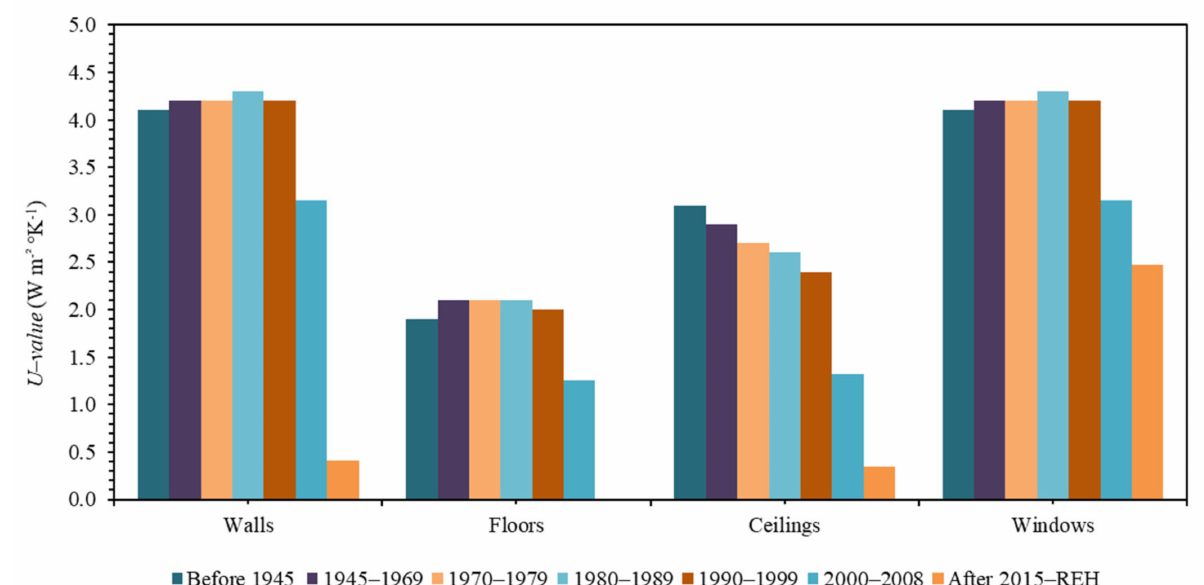
Figure 2. Evolution of the U-values of the main constructive elements in Portugal (Retrieved from: http://www.entranze. enerdata.eu/#/u-values.html (accessed on 24 September